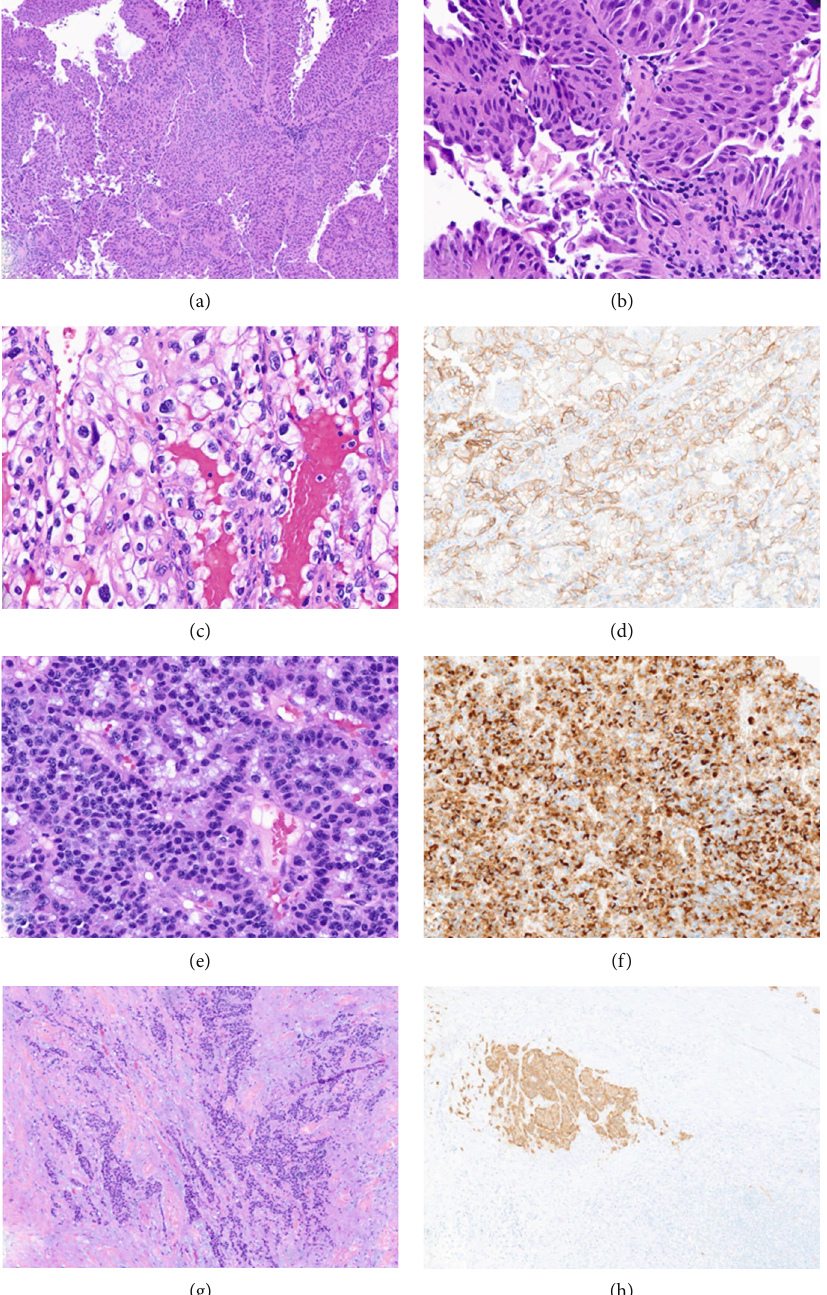
Figure 3: The histopathological fi ndings of the radical cystectomy specimen showed a small focus of noninvasive high-grade urothelial carcinoma, composed of tumor cells with nuclear atypia, pleomorphism, and hyperchromasia ((a, b) hematoxylin and eosin, × 100 and × 400 magni fi cation). The left radical nephrectomy specimen showed a clear cell renal cell carcinoma with nests of clear cells surrounded by intricately branching vascular septa and hyperchromatic nuclei ((c) hematoxylin and eosin, × 400 magni fi cation). These tumor cells demonstrated membranous staining pattern with carbonic anhydrase IX immunohistochemical stain ((d) × 200 magni fi cation). Histopathologic evaluation of the right nephrectomy specimen showed the typical nested pattern of a well-di ff erentiated neuroendocrine tumor surrounded by fi brous stroma ((e) hematoxylin and eosin, × 400 magni fi cation). Chromogranin A immunohistochemical stain showed di ff use granular staining in the tumor cells ((f) × 200 magni fi cation). One out of three inter-aorto-caval lymph nodes showed metastatic neuroendocrine carcinoma ((g) hematoxylin and eosin, × 100 magni fi cation), con fi rmed by synaptophysin immunohistochemical stain ((h) × 100 magni fi